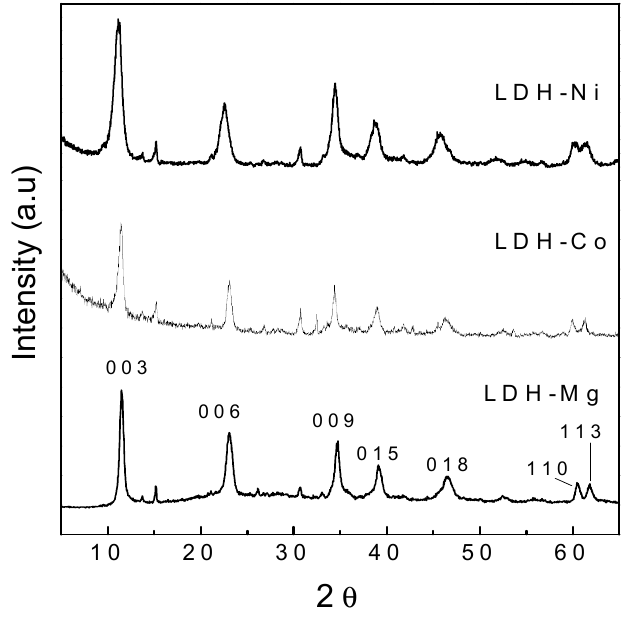
Figure 1. XRD patterns of the lamellar double hydroxides (LDHs).